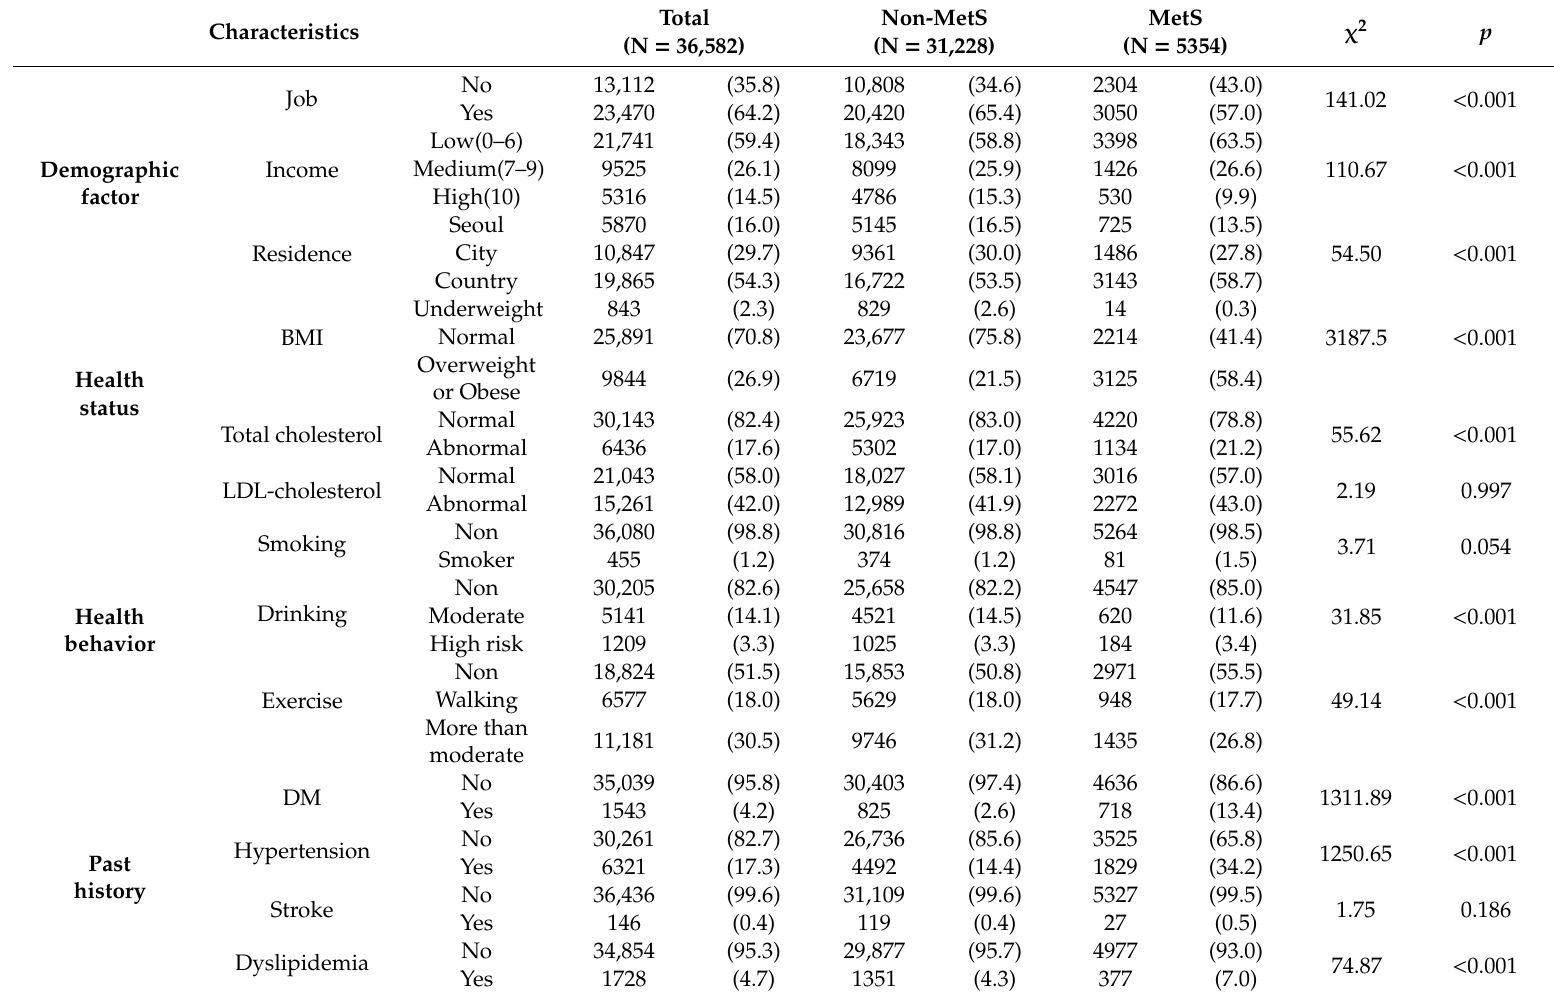
Table 3. General characteristics of the